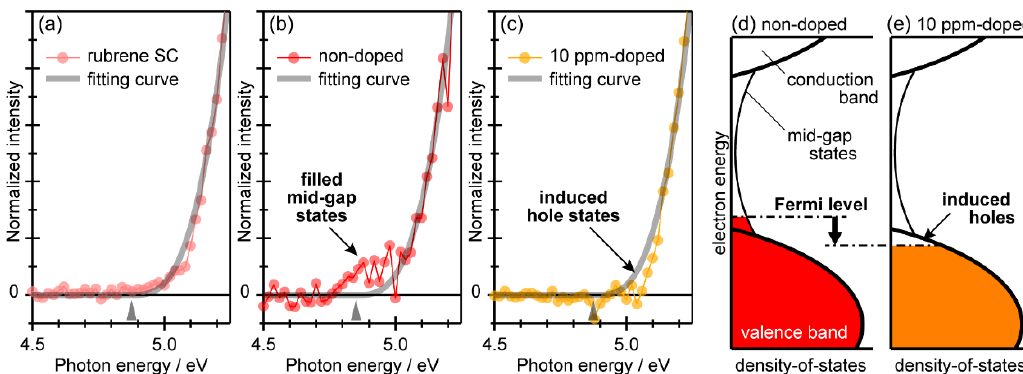
Figure 4. (a – c) Magnified PYS spectra of the (a) bare rubrene single crystal, (b) non-doped homoepitaxial rubrene overlayer, and (c) 10-ppm-doped homoepitaxial rubrene. The vertical scales of each graph are normalized by the intensity factor “ A ” of the cube-root function. The fitting curves and estimated ionization energy positions for the respective spectra are displayed as thick gray curves and gray wedge marks, respectively. (d, e) Schematic drawings of the expected electronic states of the (d) non-doped and (e) 10-ppm-doped homoepitaxial rubrene samples.